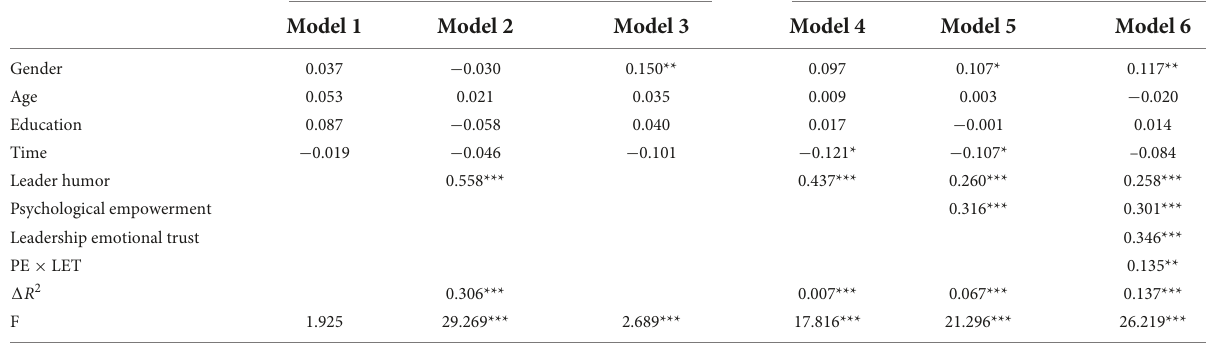
TABLE 3 Results of the hierarchical regression model.